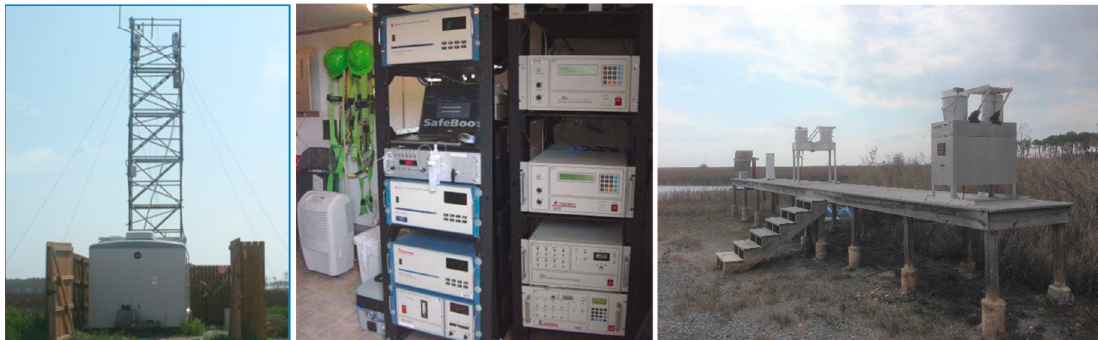
Figure 2. Left : the 10-m measurement tower at the Grand Bay site, showing two sets of Tekran collection units for gaseous elemental mercury (GEM), gaseous oxidized mercury (GOM), and particulate-bound mercury (PBM). Middle : instruments to measure mercury and chemical species inside a climate-controlled trailer adjacent to the tower. Right : precipitation collectors for National Acid Deposition Program’s Mercury Deposition Network and National Trends Network at the site to measure mercury wet deposition and precipitation chemistry.